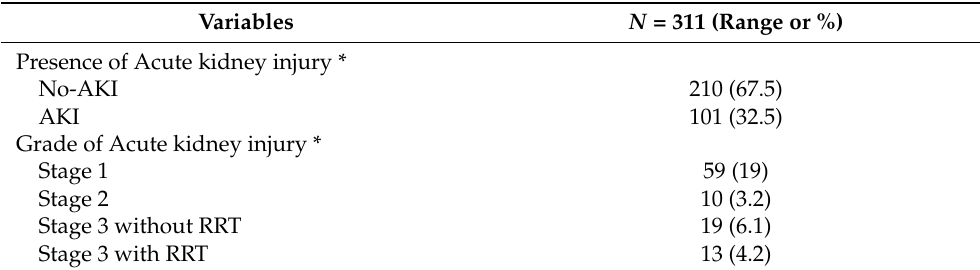
Table 3. AKI classification of patients after abdominal surgery.